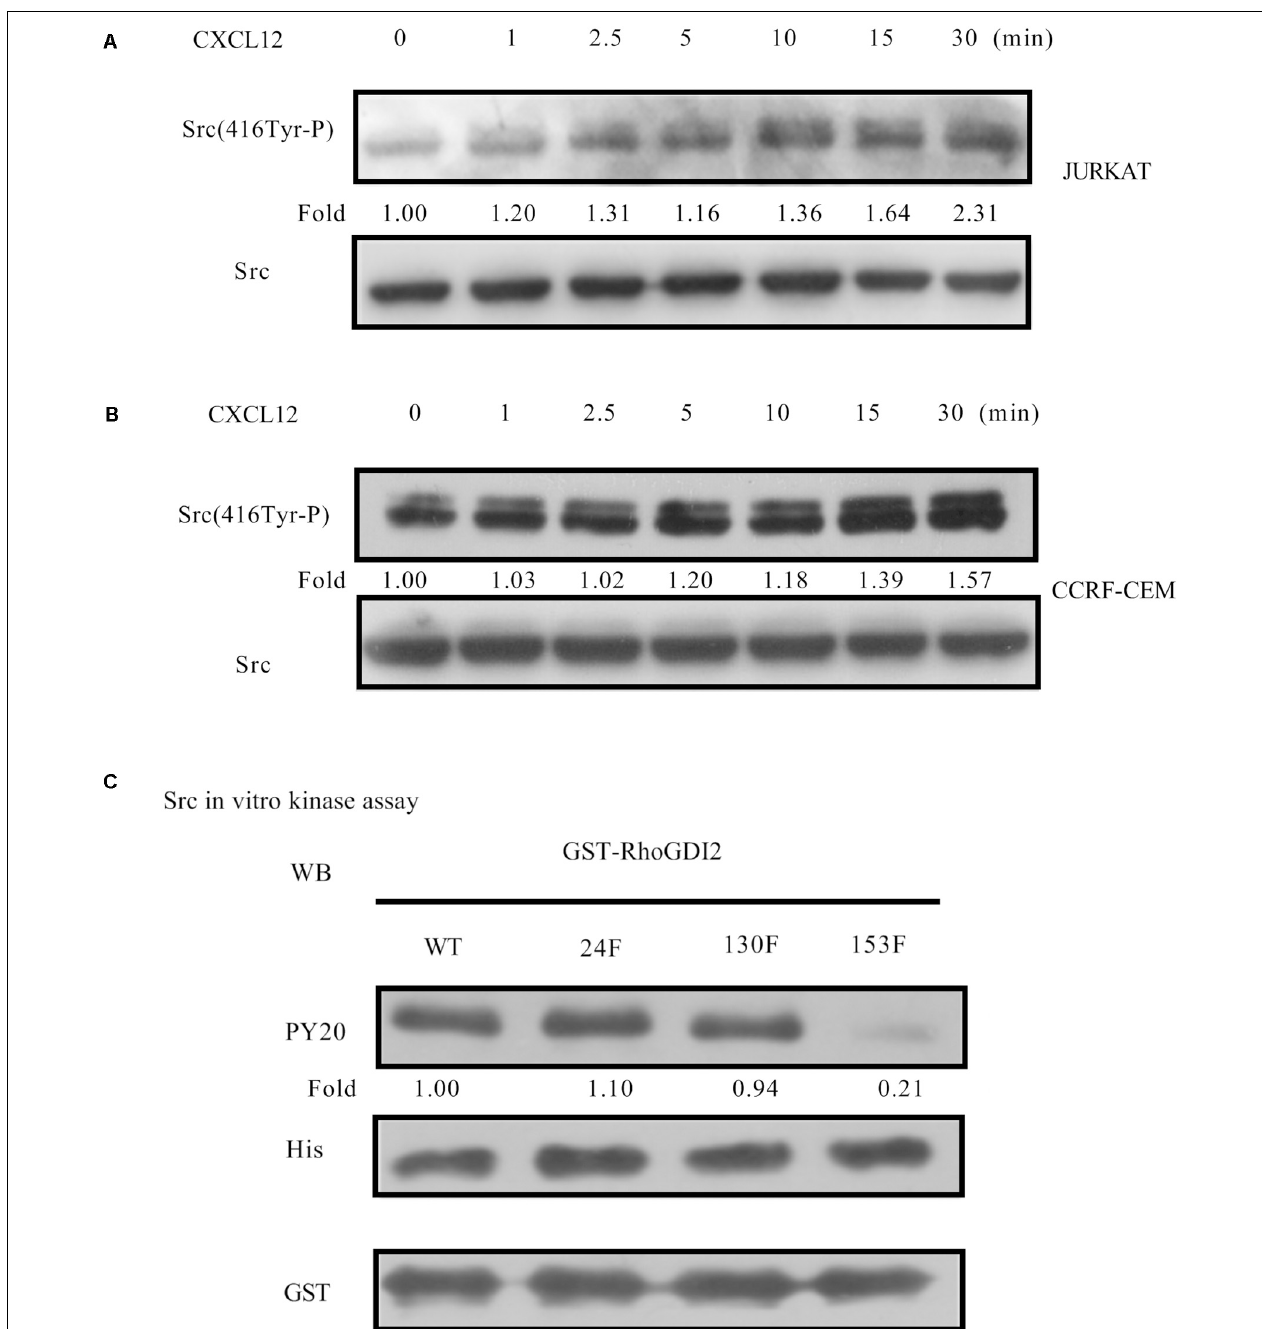
FIGURE 5 | CXCL12 can activate Src in T-ALL cells. (A,B) Starved JURKAT or CCRF-CEM cells were incubated with CXCL12, and then cell lysates were prepared: 60 µ g of cell lysates were subject to SDS-PAGE and Western blot assay, using active Src antibody, Src(416Tyr-P). (C) Then, 1.2 µ g of GST-RhoGDI2-WT, GST-RhoGDI2-Y24F, GST-RhoGDI2 Y130F, or GST-RhoGDI2 Y153F were incubated with 600 ng recombinant human active Src (His-tag) in the in vitro kinase assay. Samples were boiled in 1 × Loading buffer at 98 ◦ C for 5 min and then resolved by SDS-PAGE. PY20, His antibody, or GST antibody was used in the Western blot assay to detect the phosphorylation of RhoGDI2, the amount of active Src, or RhoGDI2 (WT or mutated) that were used in each in vitro kinase assay, respectively. Western blot bands were analyzed using Image Pro Plus 6.0. Fold changes of active Src were normalized according to total Src. Bands of phosphorylated GST-RhoGDI2 (PY20) were normalized according to WT or mutants of GST-RhoGDI2 (GST) that were used in each kinase assay.